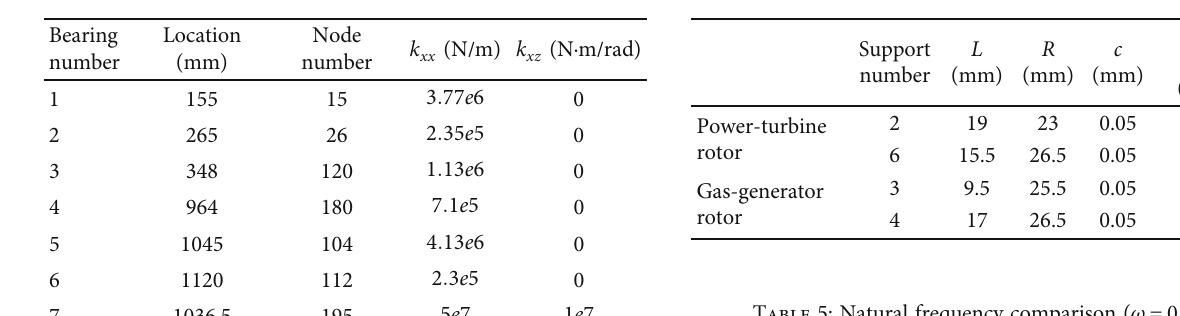
Table 2: Sti ff ness of squirrel cages.